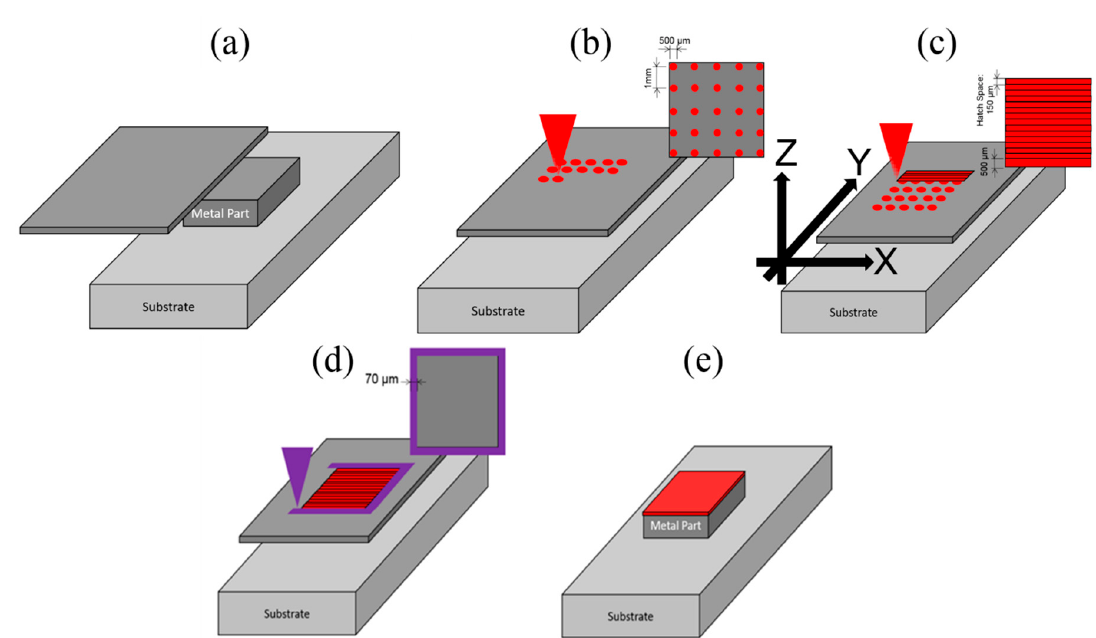
Figure 2. Schematic illustrations of the five steps in laser-foil-printing for the processing of each layer: ( a ) foil feeding; ( b ) spot welding; ( c ) pattern welding; ( d ) contour cutting; ( e ) excess foil removing.